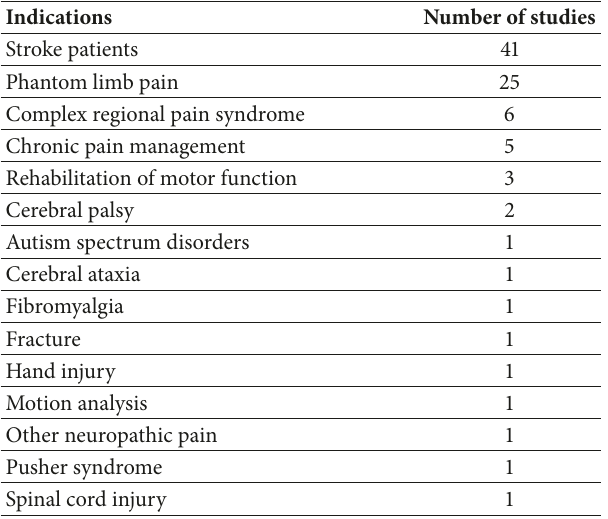
Table 18: Suggested indications for the use of second-generation mirror therapy in included studies (the study was not necessarily conducted on this type of